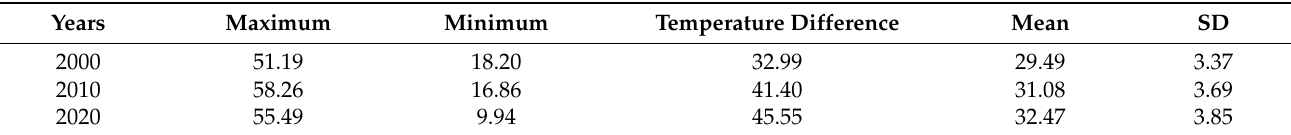
Table 3. Maximum, minimum, temperature difference, mean and SD of LST from 2000 to 2020.